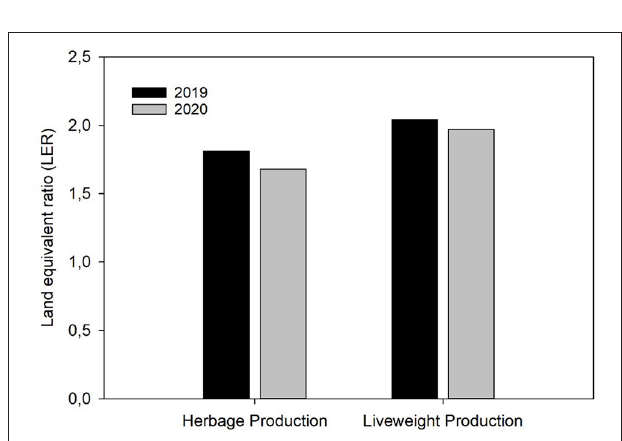
FIGURE 9 | Land equivalent ratio of herbage (kg DM ha − 1 ) and liveweight production (LWP, kg ha − 1 d − 1 ) in 2019 and